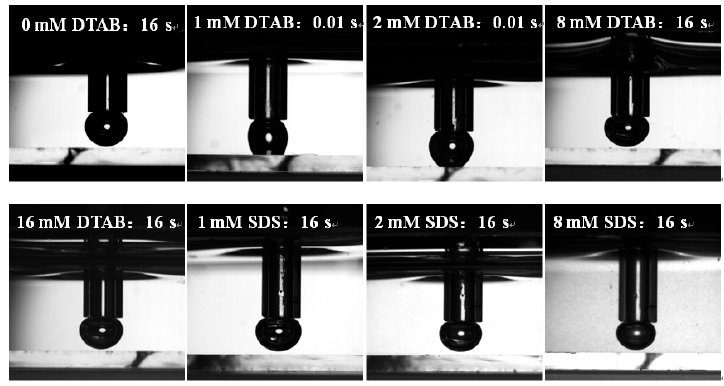
Figure 9. Effect of DTAB and SDS on the attachment behaviour between hydrophilic glass and bubble.